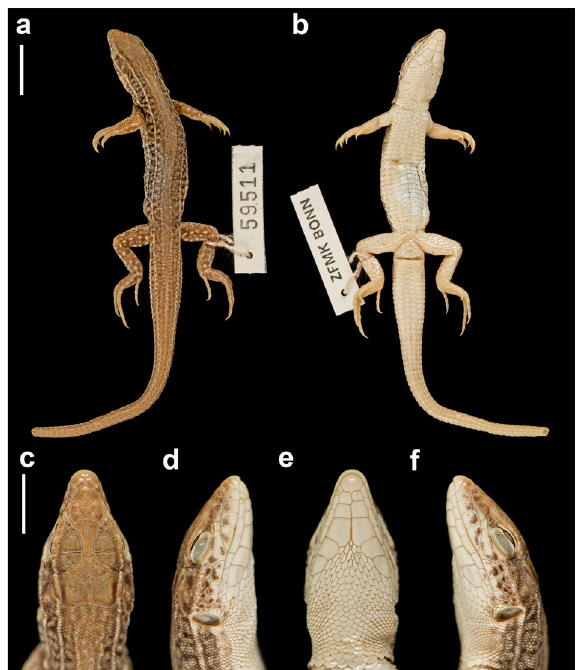
Figure 2. Photographs of the newly sequenced specimen of A. guineensis (ZFMK 59511) with dorsal and ventral whole animal shots and head close ups (dorsal, ventral and both laterals). The white line represents 1 cm (top) and 0.5 cm (bottom), respectively. Photographs taken by M. Flecks